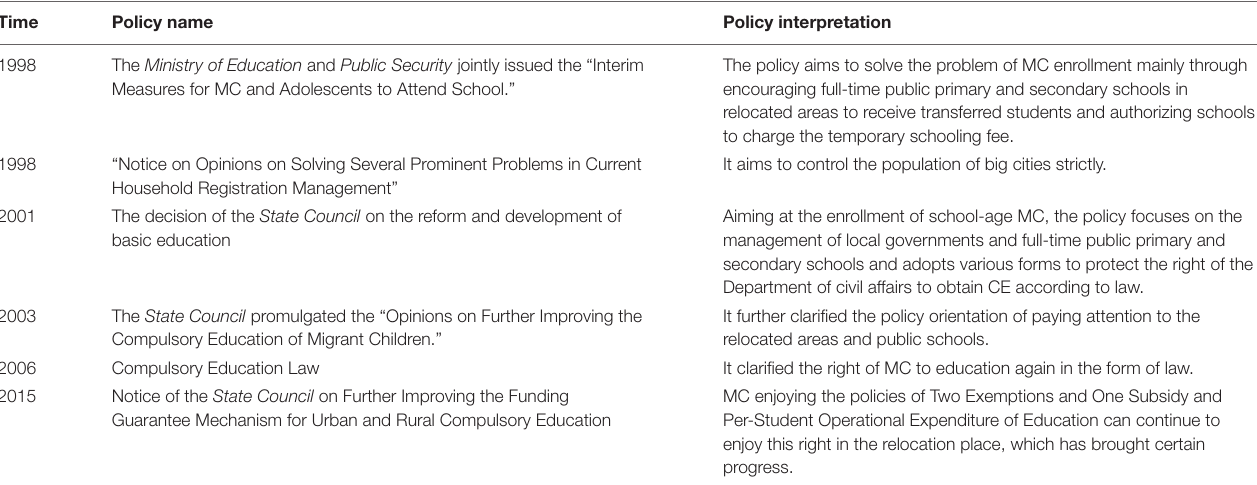
TABLE 1 | Promulgation of the education policys (Eps) for migrant children